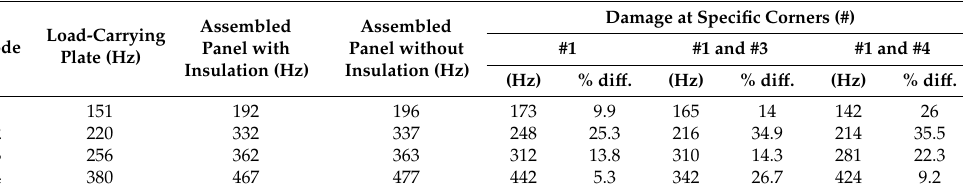
Table 3. Summary of the change in natural frequencies of the test cases.